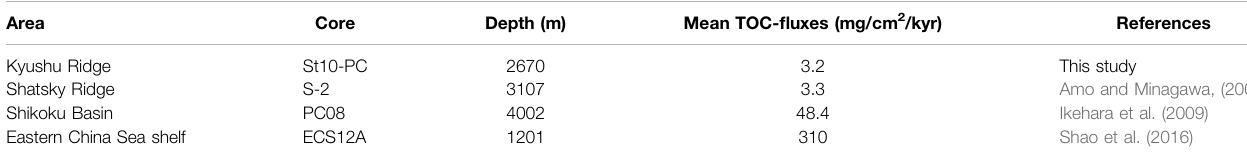
TABLE 2 | Comparison of OC fl uxes in cores from the Northwest Paci fi c Ocean. Area Core Depth (m) Mean TOC- fl uxes (mg/cm 2